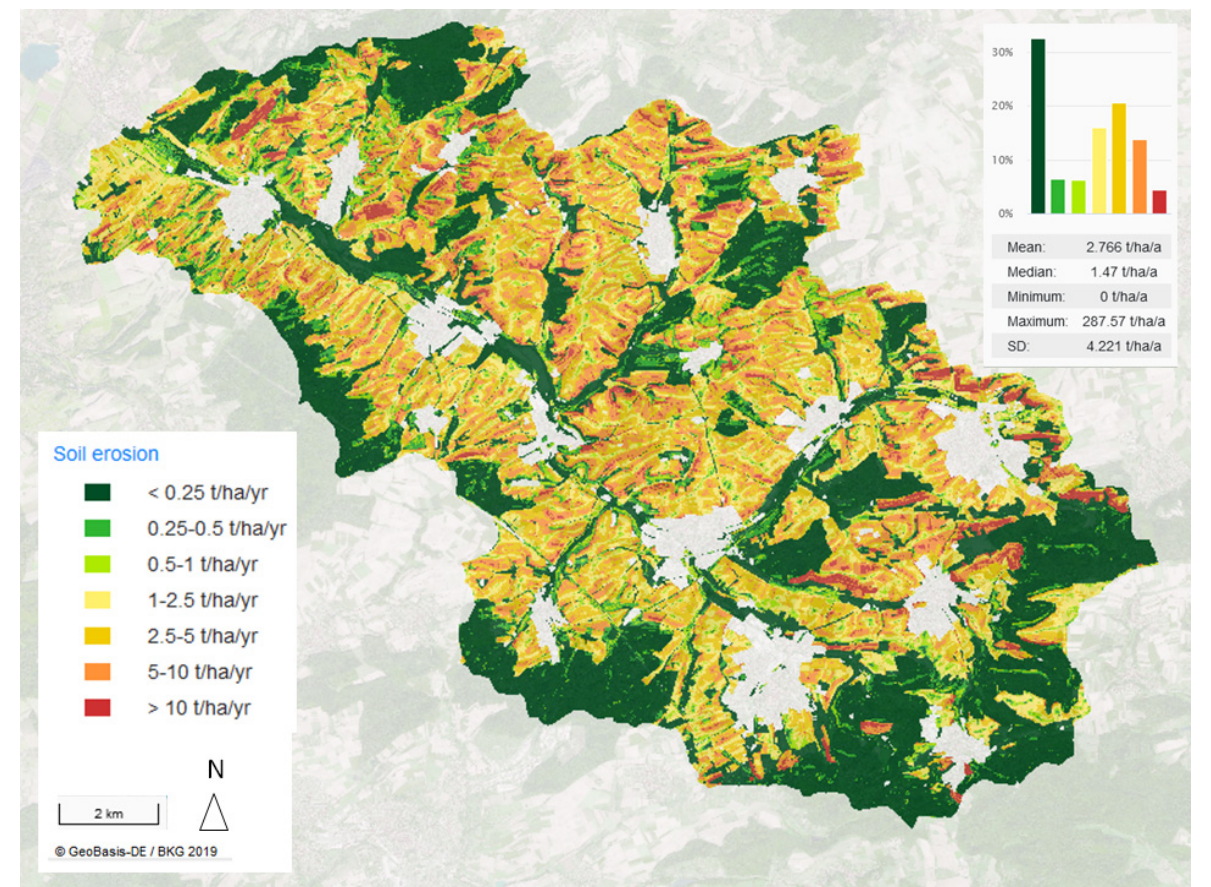
Figure 5. Modeled soil loss in the Kraichbach catchment.